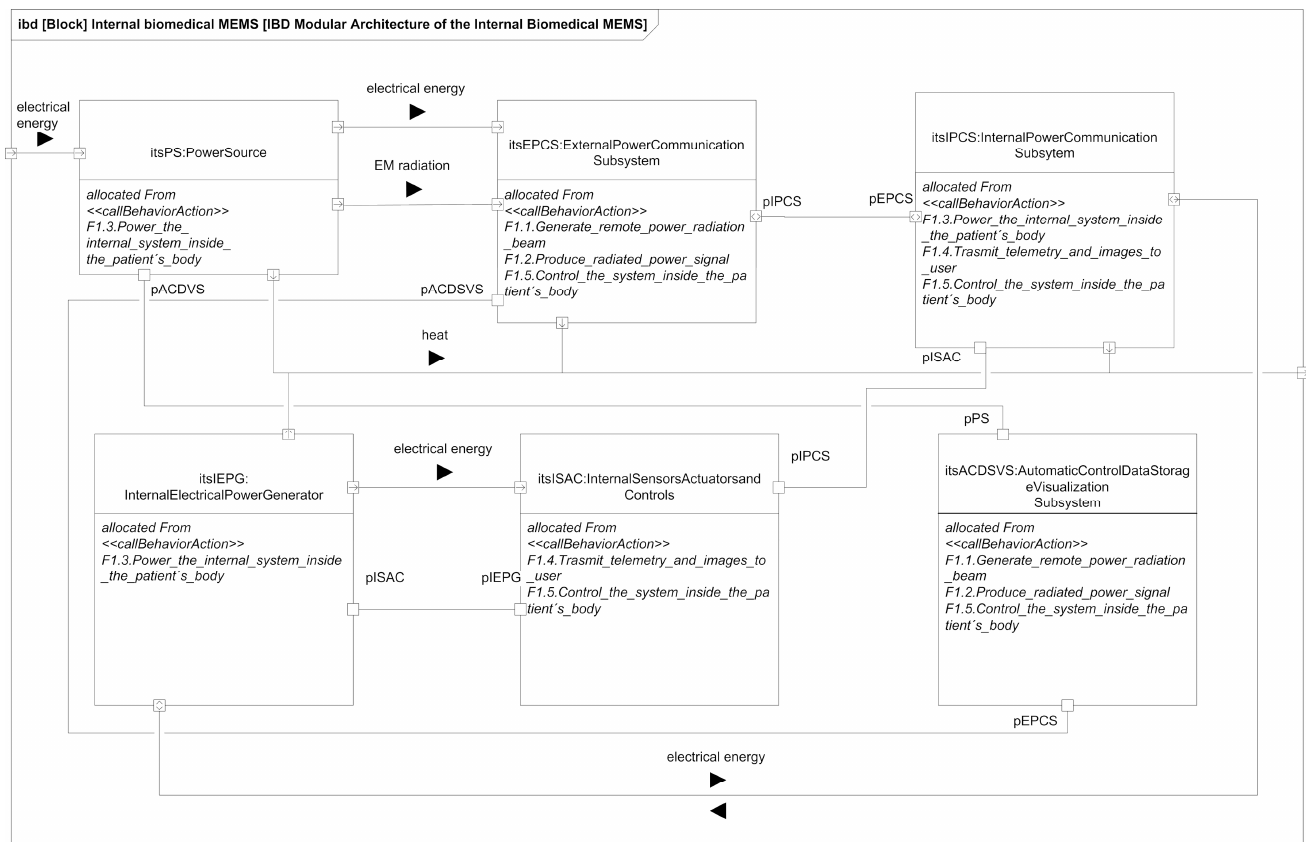
Figure 2. Logical blocks of a biomedical implanted system with WPT.